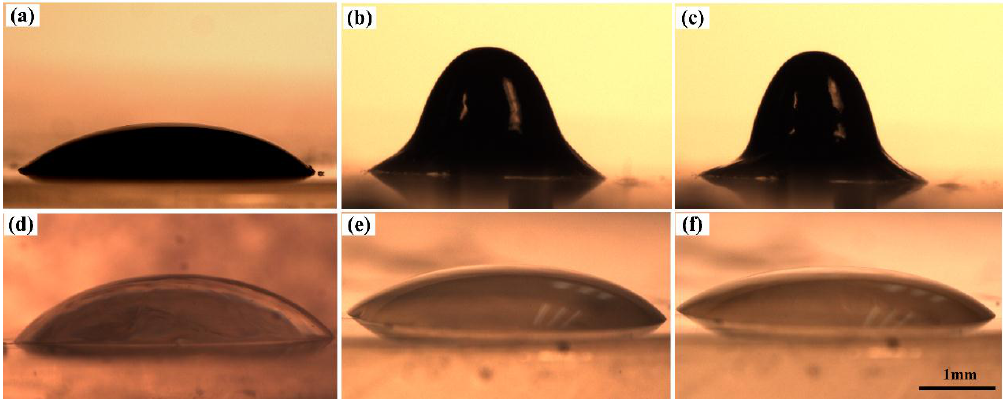
Figure 1. PVP/Fe 3 O 4 ferrofluid (PFF) droplet morphology ( a ) in air, ( b ) under the magnetic field, and ( c ) under the coincident magnetic and electric fields. Pure PVP droplet morphology ( d ) in air, ( e ) under the magnetic field, and ( f ) under the coincident magnetic and electric fields. The applied external magnetic field and electric voltage were about 35 mT and 5 kV, respectively. All the subfigures share the same scale .